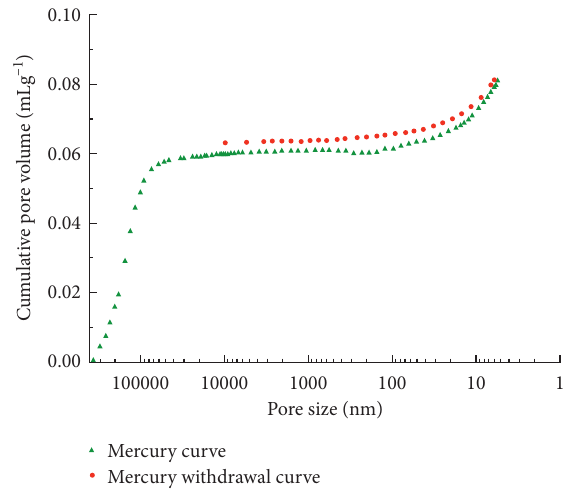
Figure 1: Experimental curves of cumulative pore volume with